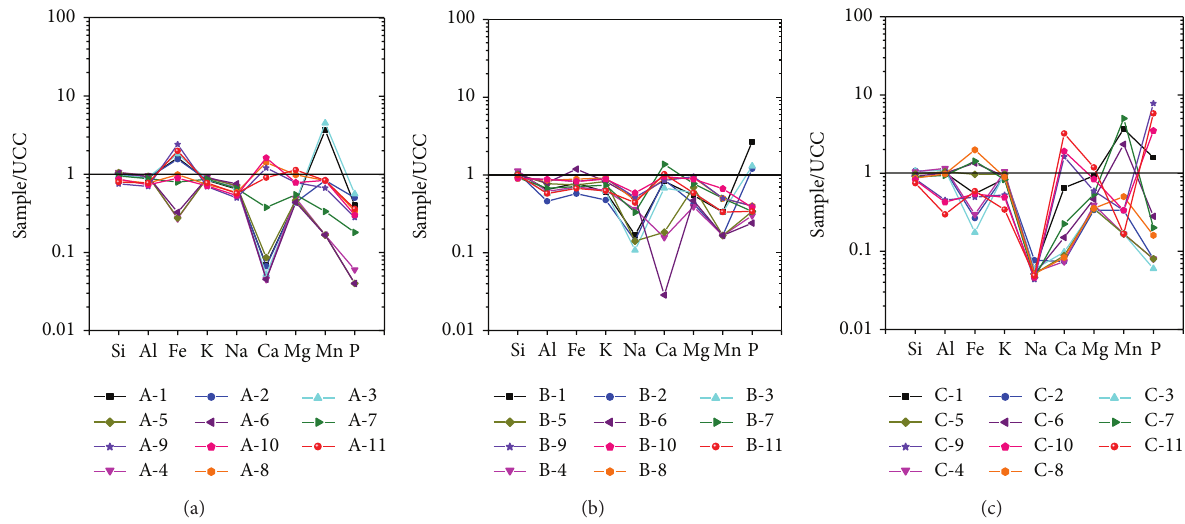
Figure 2: Spider plots showing the UCC-normalized pattern of major elements for each sample of the Shuijintuo Formation black shale in Chengkou